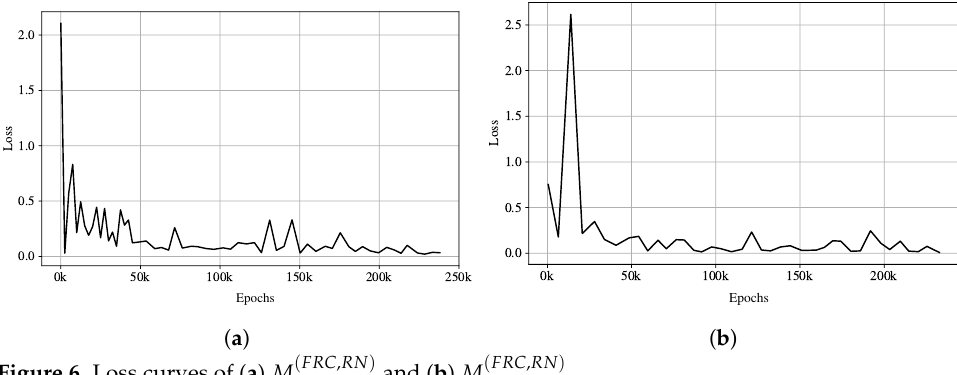
Figure 6. Loss curves of ( a ) M